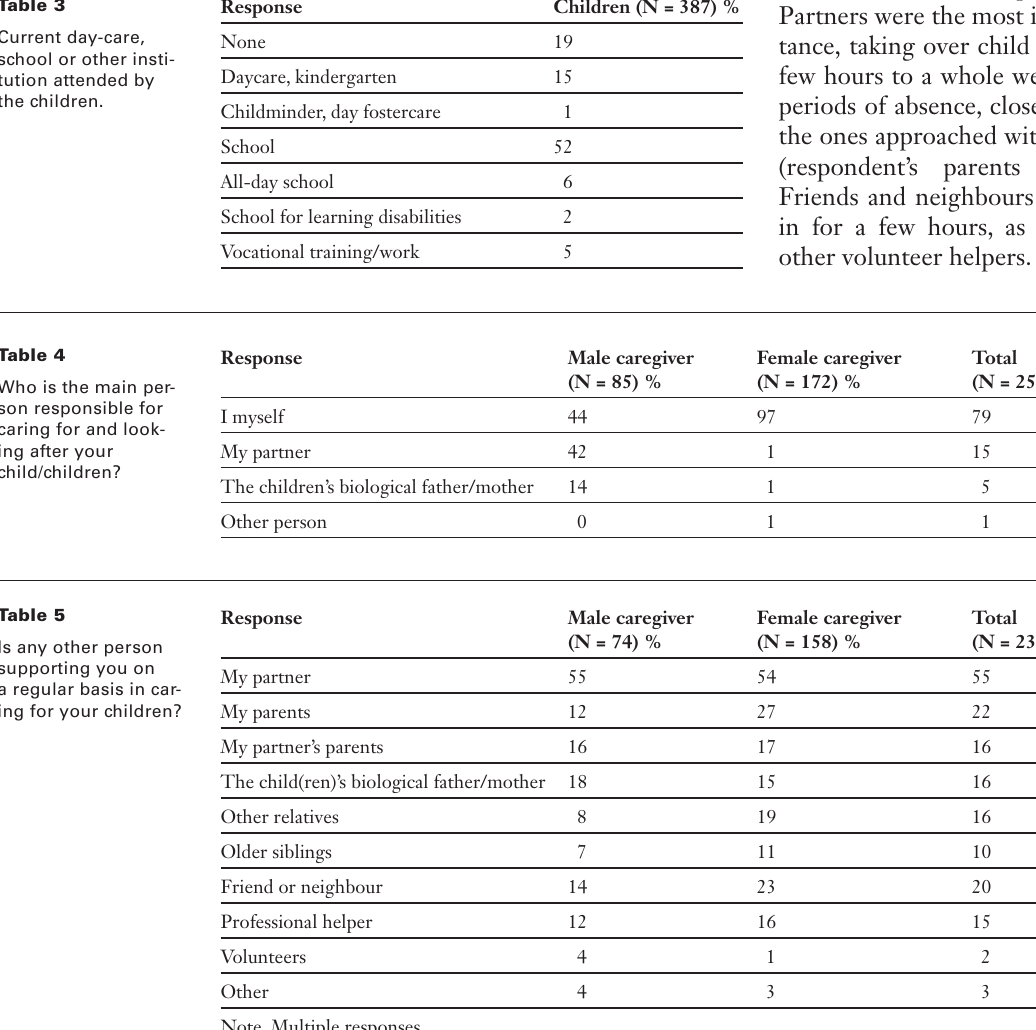
Current day-care, school or other insti- tution attended by the children.